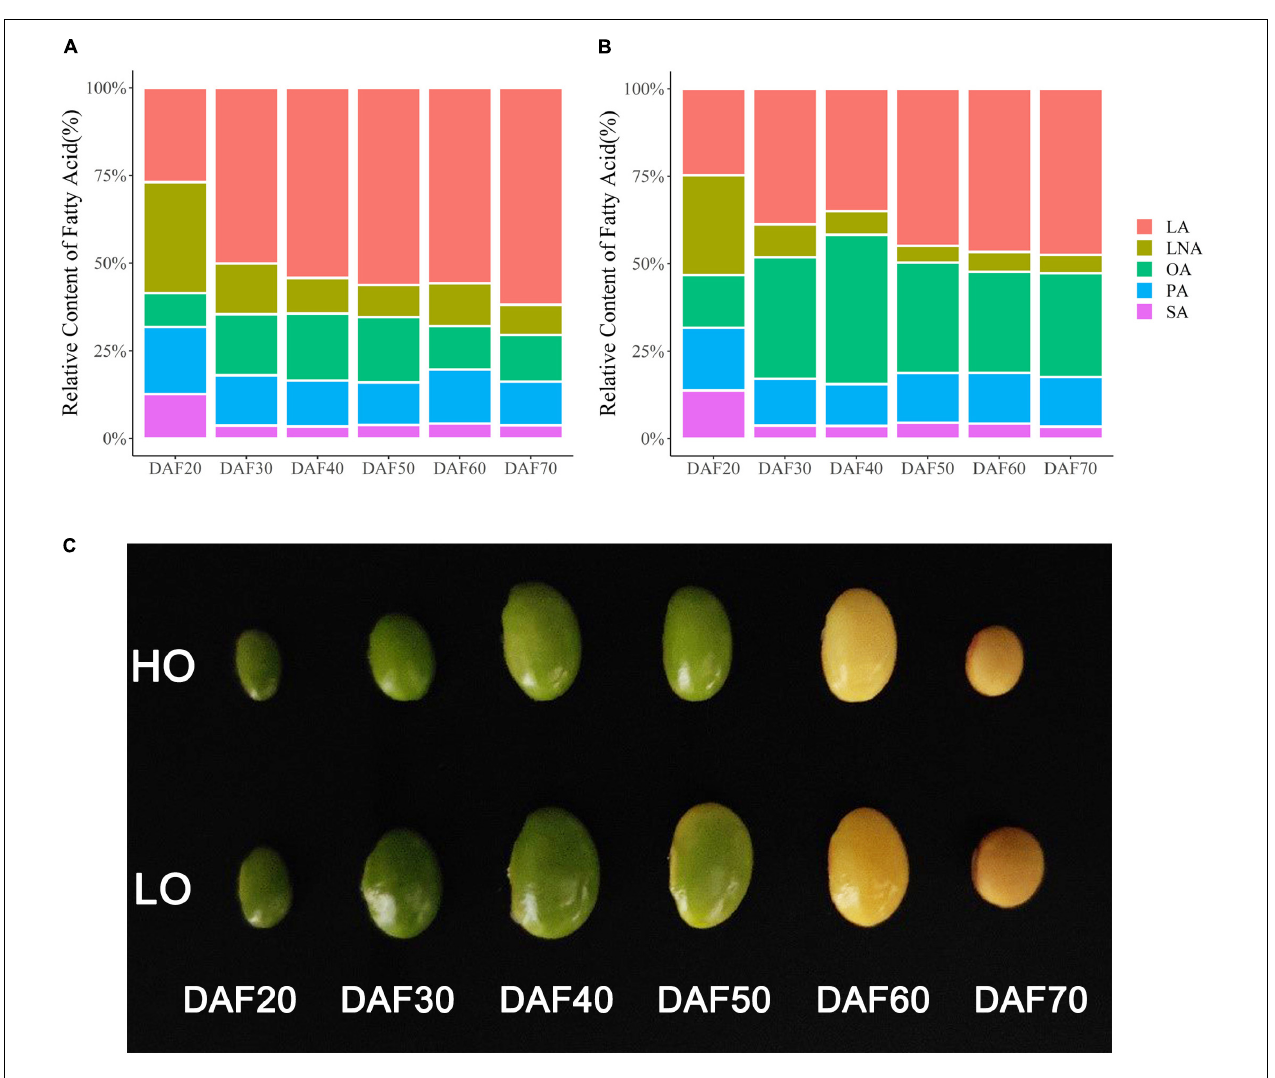
FIGURE 2 | Fatty acid profiles of two materials at different periods. (A) Fatty acid profiles of LO at different periods. (B) Fatty acid profiles of HO at different periods. (C) Soybean seeds at different development stages. PA, palmitic acid; SA, stearic acid; OA, oleic acid; LA, linoleic acid; LNA, linolenic